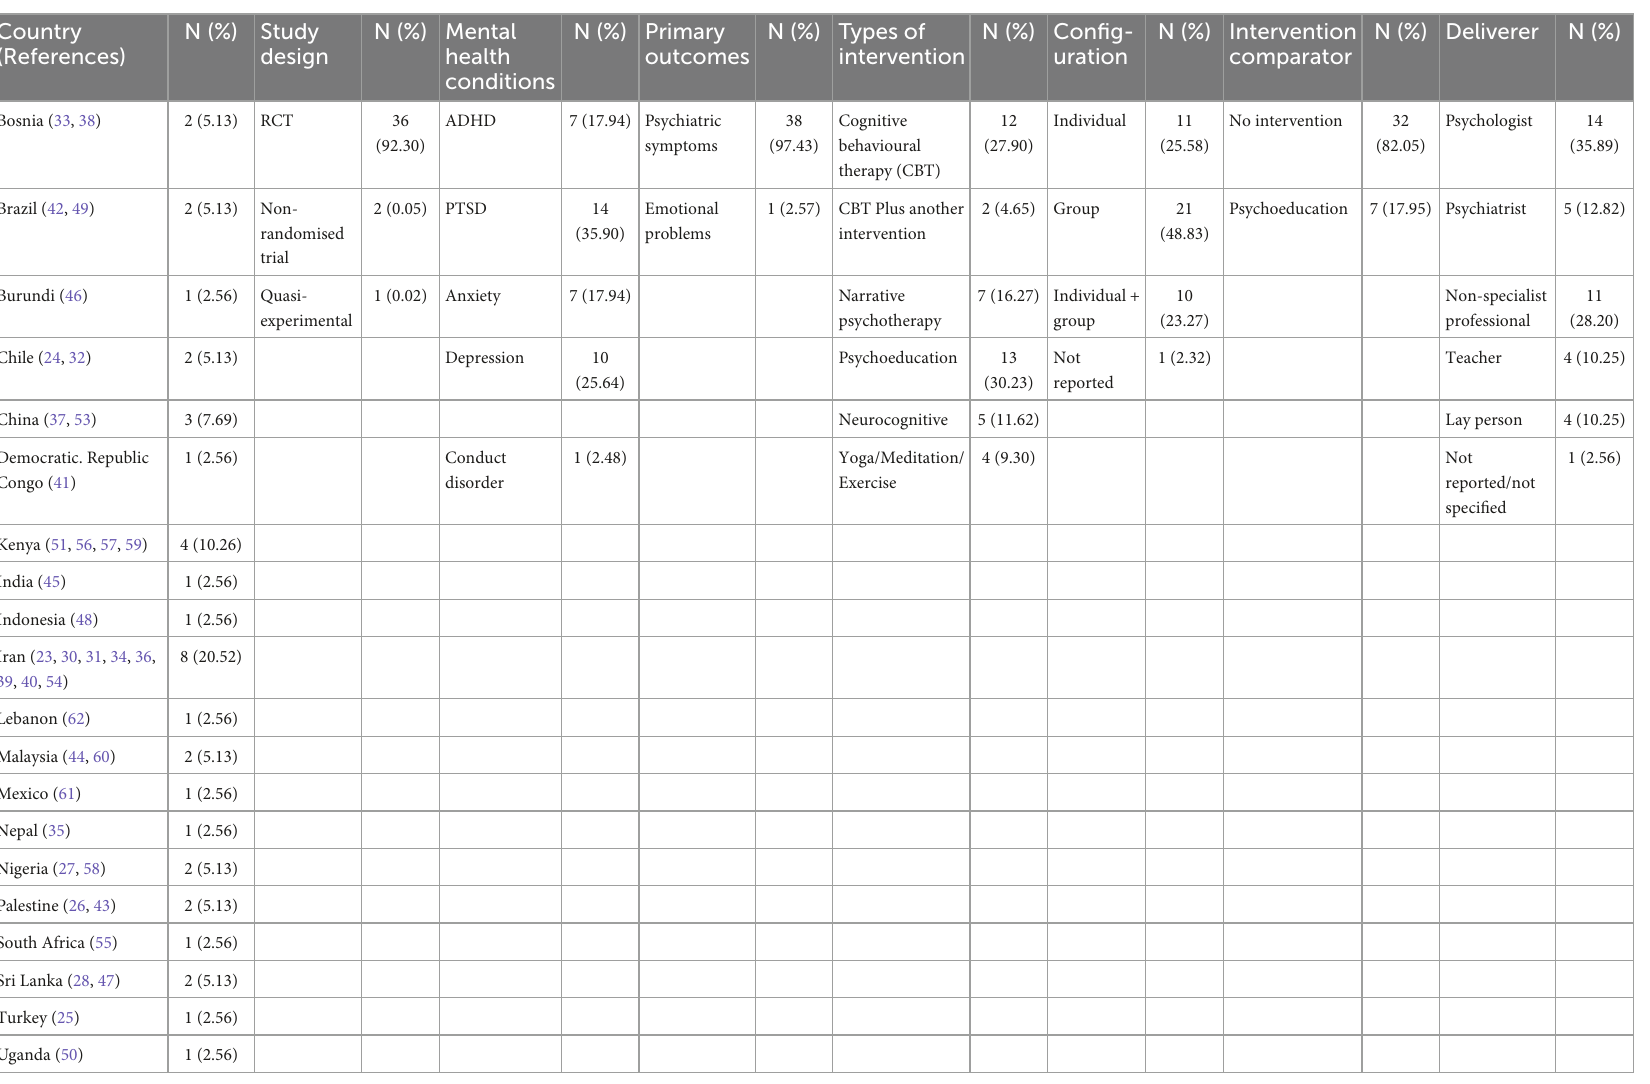
TABLE 2 Synthesis of the studies included in the systematic review ( n =